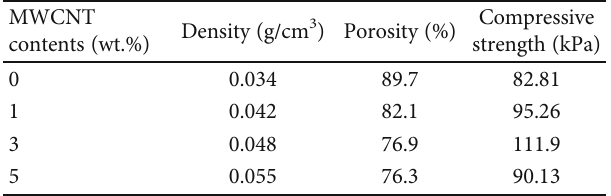
Figure 2: FT-IR spectra of original, acid-treated, and aniline- modi fi ed MWCNTs. Table 1: Density, porosity, and compressive strength of PU/MWCNT foam nanocomposites at various MWCNT